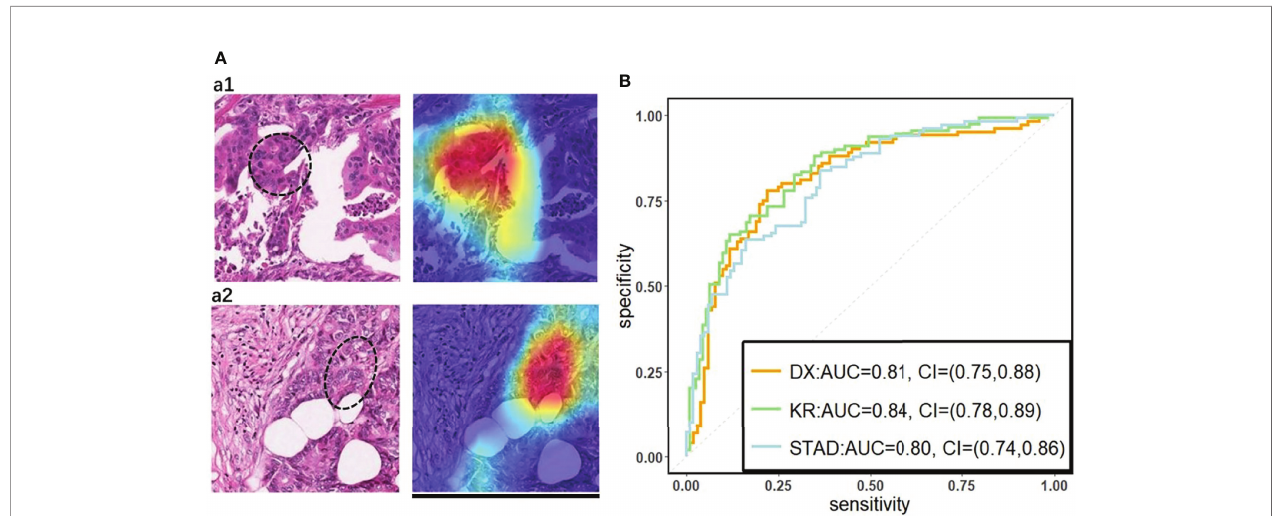
FIGURE 1 | (A) The original tile and the corresponding heatmap output by the GCAM. The image in the left of (A1) and (A2) display tiles from the TCGA-CC-DX dataset labeled with MSI and MSS, respectively. The ellipse upon the images corresponds the most contributed region revealed by GCAM. In the heatmaps, the brighter region contributes more to the classi fi cation. For instance, the red one is the most highlighted area, while the blue regions contribute limitedly. Scale bar, 256 µm (B) Patient-level receiver operating characteristic (ROC) curve for classifying MSI versus MSS in the three datasets with deep learning. The 95% con fi dence intervals (CI) were computed by the bootstrap method.